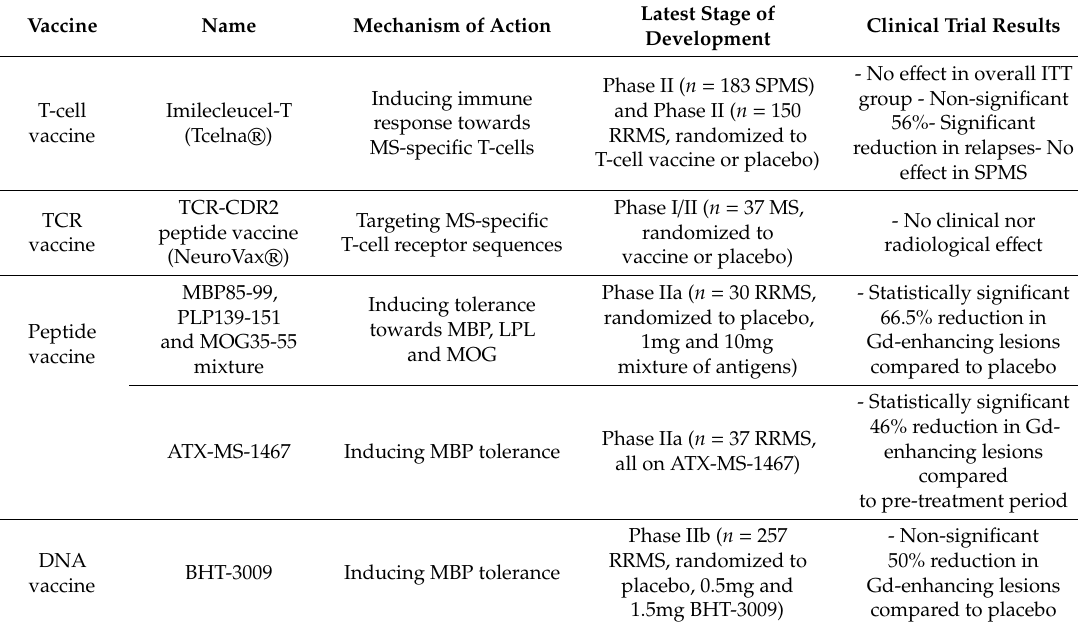
Table 2. Vaccine development for multiple sclerosis